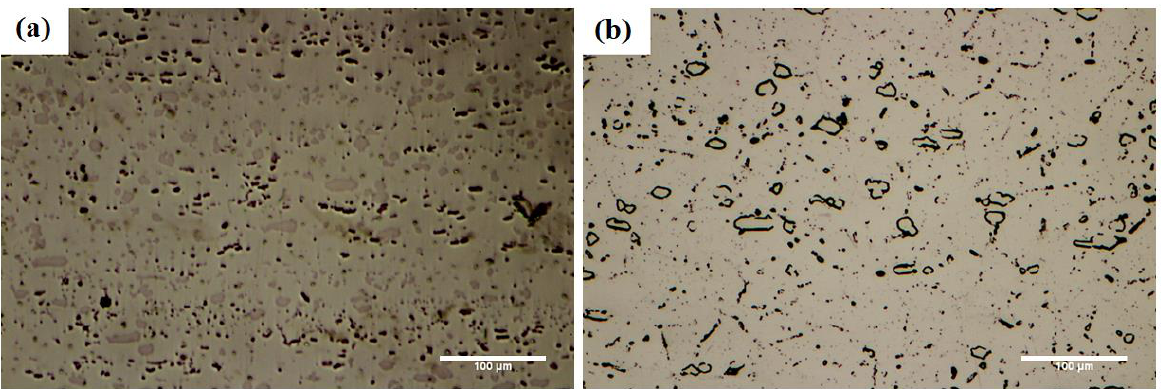
Figure 4. The optical microscopy of the microstructure of super-ferritic stainless steel 446: ( a ) as-received and ( b ) 1050 °C/60 min conditions. Table 3. Chemical composition of sigma phase at different conditions (wt.%).